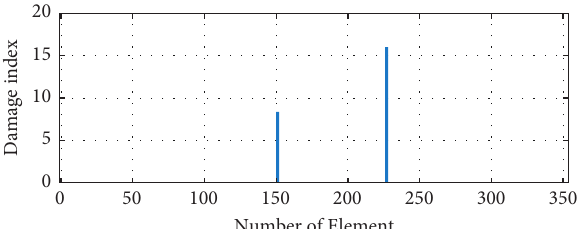
Figure 28: Results of multidamage case D4 using MCA-DI (setback building).